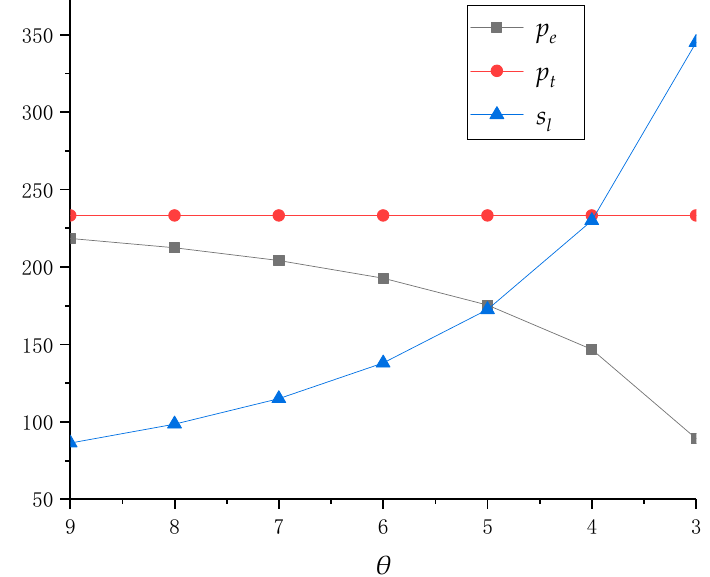
Figure 5. Price and service changes with different μ when Θ = 0.4.